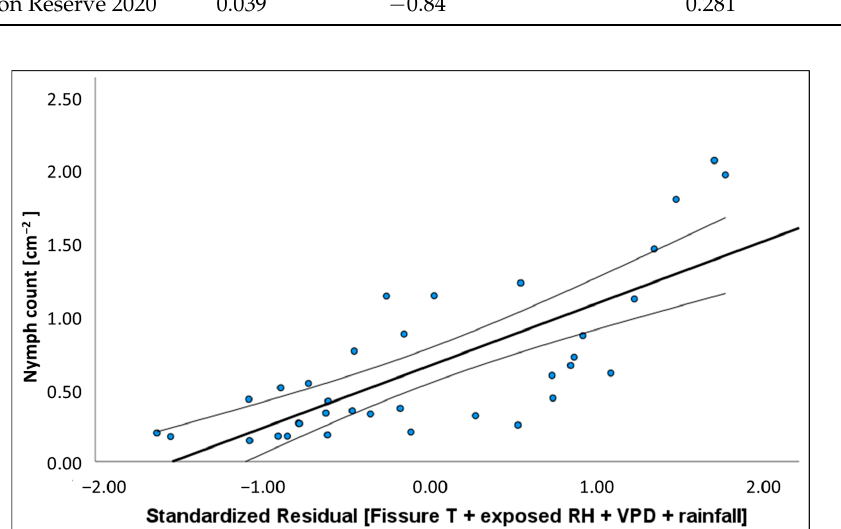
Table A9. Summary of climate regression models predicting Marchalina hellenica density. Climate records used in models represent the fortnightly mean value of daily maximum, except rainfall; recorded cumulatively in millimetres. N = 34 for each regression analyses.